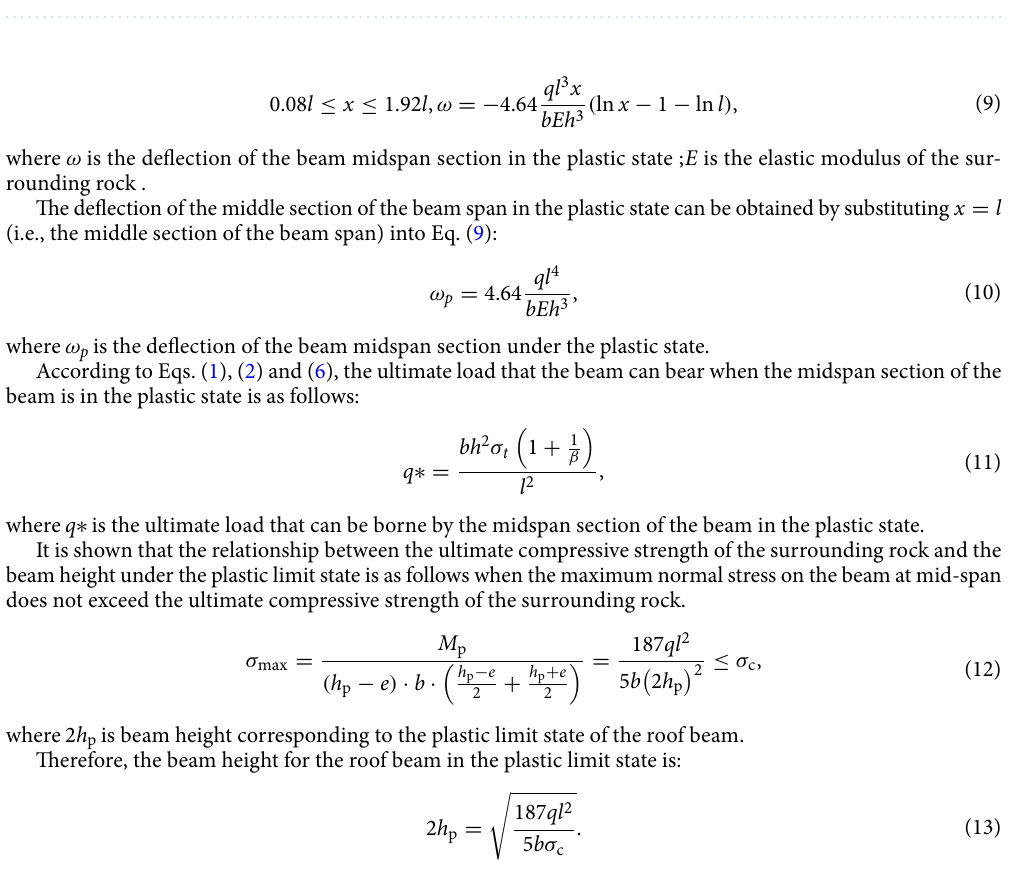
Figure 3. Schematic of equivalent uniform load on surrounding rock of roadway